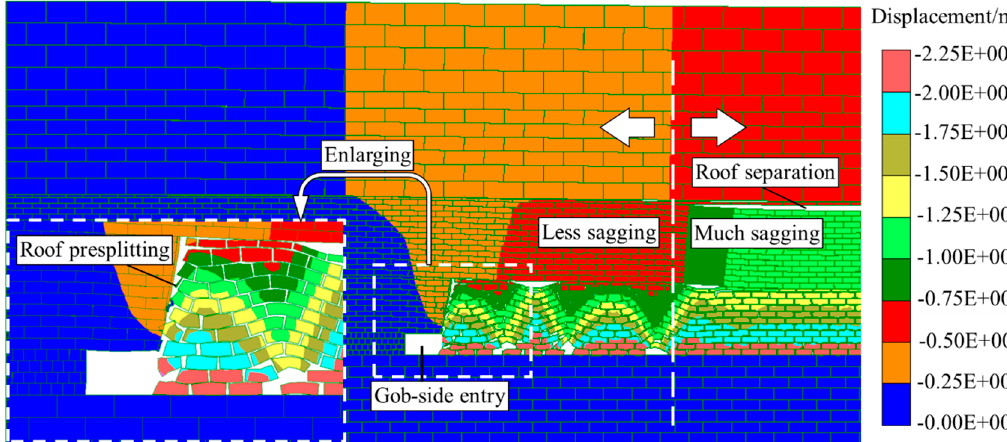
Figure 6. Numerical simulation result of surrounding rock movement and vertical displacement.